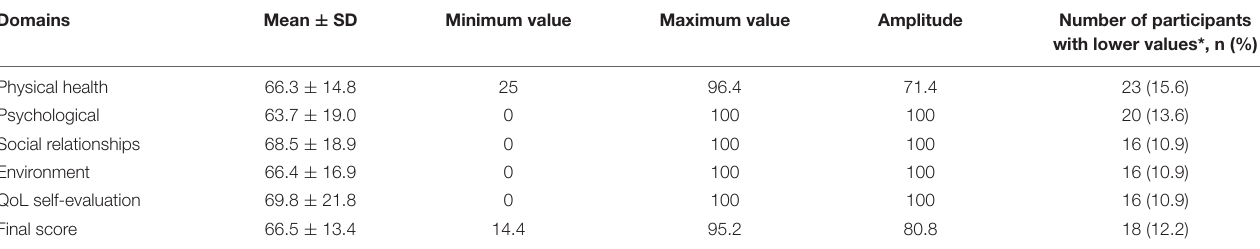
with lower values*, n (%)